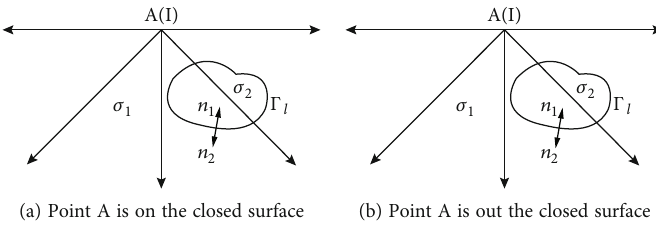
Figure 11: Point source 2-D electric fi eld sketch